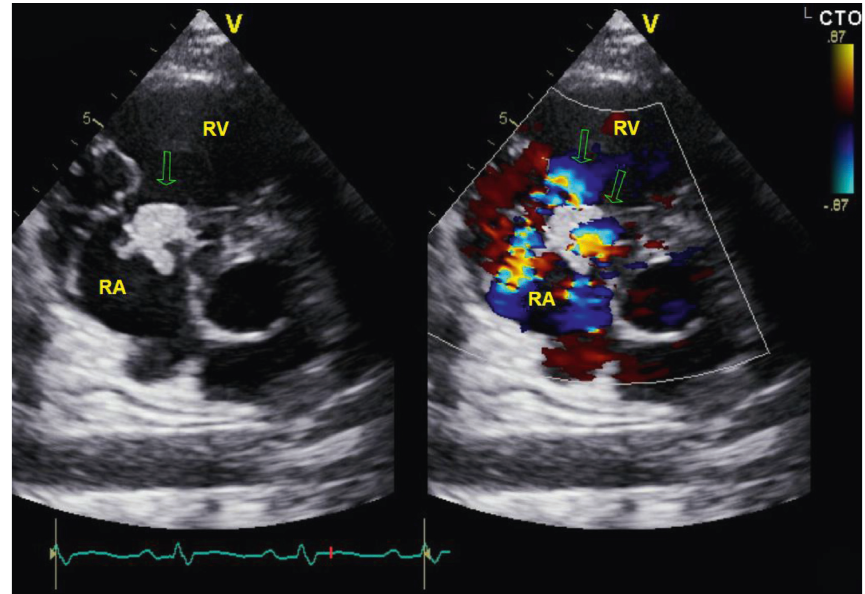
Figure 5: Parasternal short access view color flow Doppler showing the tricuspid regurgitation jet off axis and